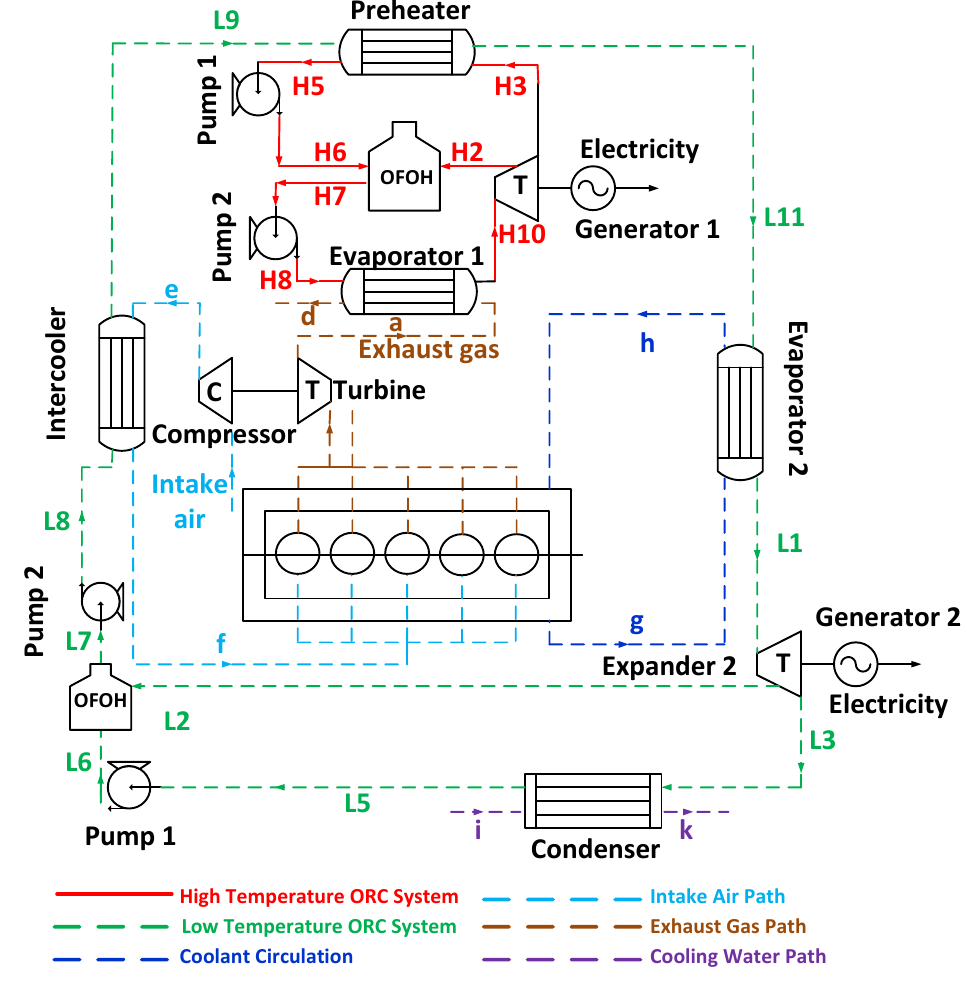
Figure 1. Schematic view of the regenerative dual-loop organic Rankine cycle (ORC) with Open Feed Organic Heater (OFOH).